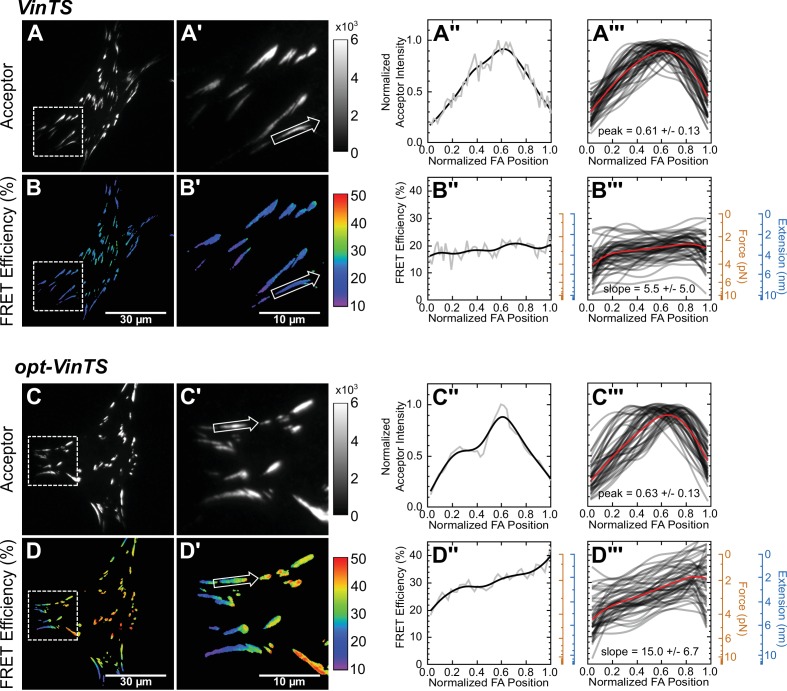
Optimized tension sensor reveals sub-FA gradients in vinculin tension.(panels A and B) Representative images of subcellular distribution of VinTS (Grashoff et al., 2010) (A, A’) along with representative (A’’) and aggregate (A’’’) line scans of single FAs of size >0.5 μm2 and axis ratio >1.5; corresponding masked FRET images (B, B’) and line scans (B’’, B’’’); n = 55 FAs from n = 11 cells from three independent experiments; averaged intensity and FRET profiles in red. (panels C and D) As in panels (A and B), but with optimized opt-VinTS construct; n = 49 FAs from n = 10 cells from three independent experiments.